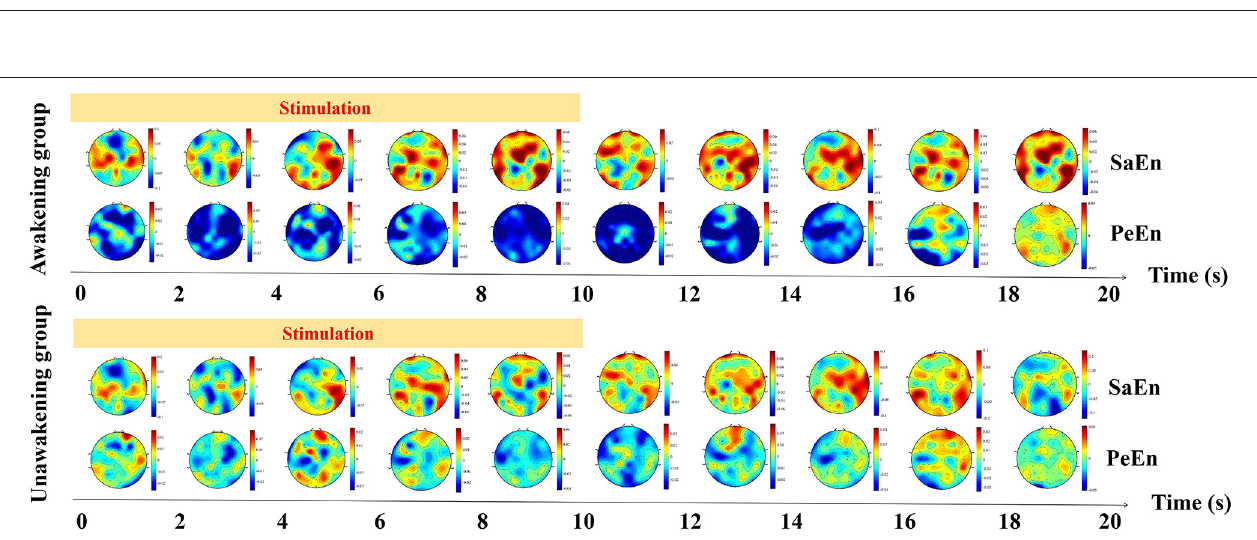
FIGURE 4 | The dynamic changes of entropy along the time. SaEn, sample entropy; PeEn, permutation entropy.